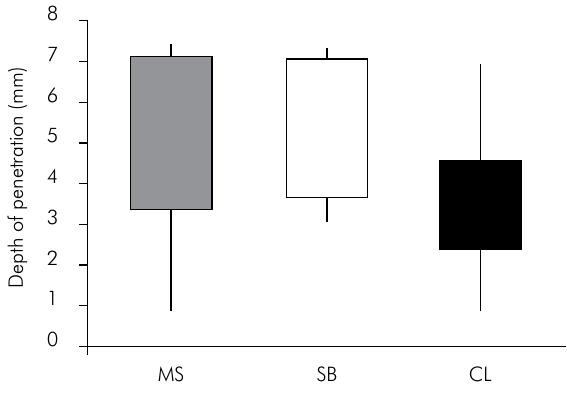
Figure 2. Impact of the obturation technique on filling material penetration (mm) into lateral canals of the middle third region.